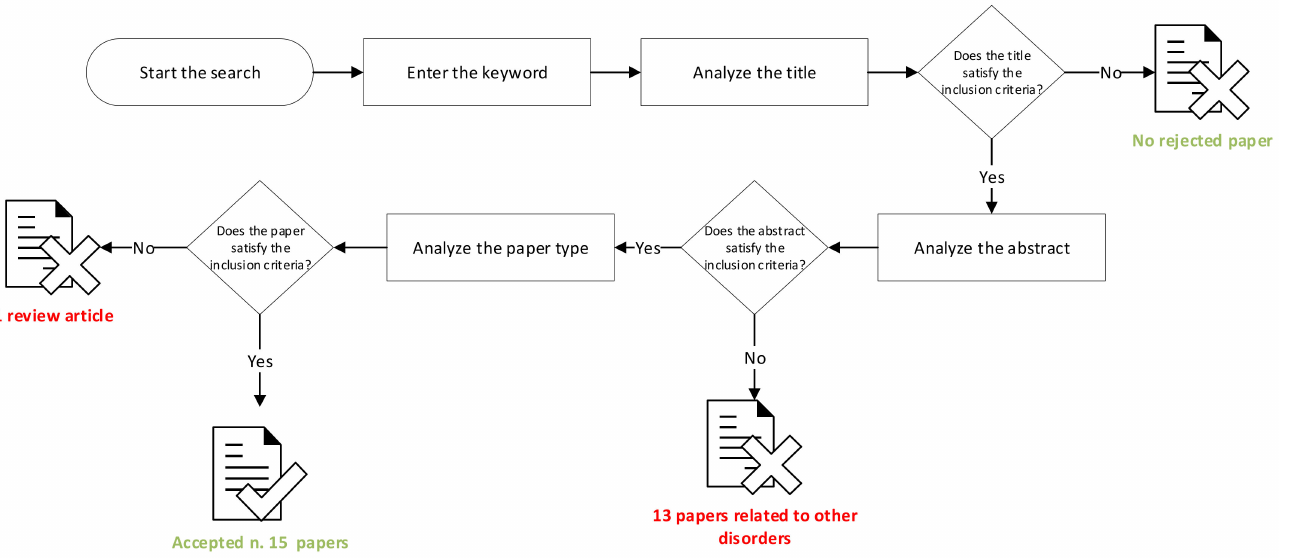
Figure 3. Schematic representation about included and excluded